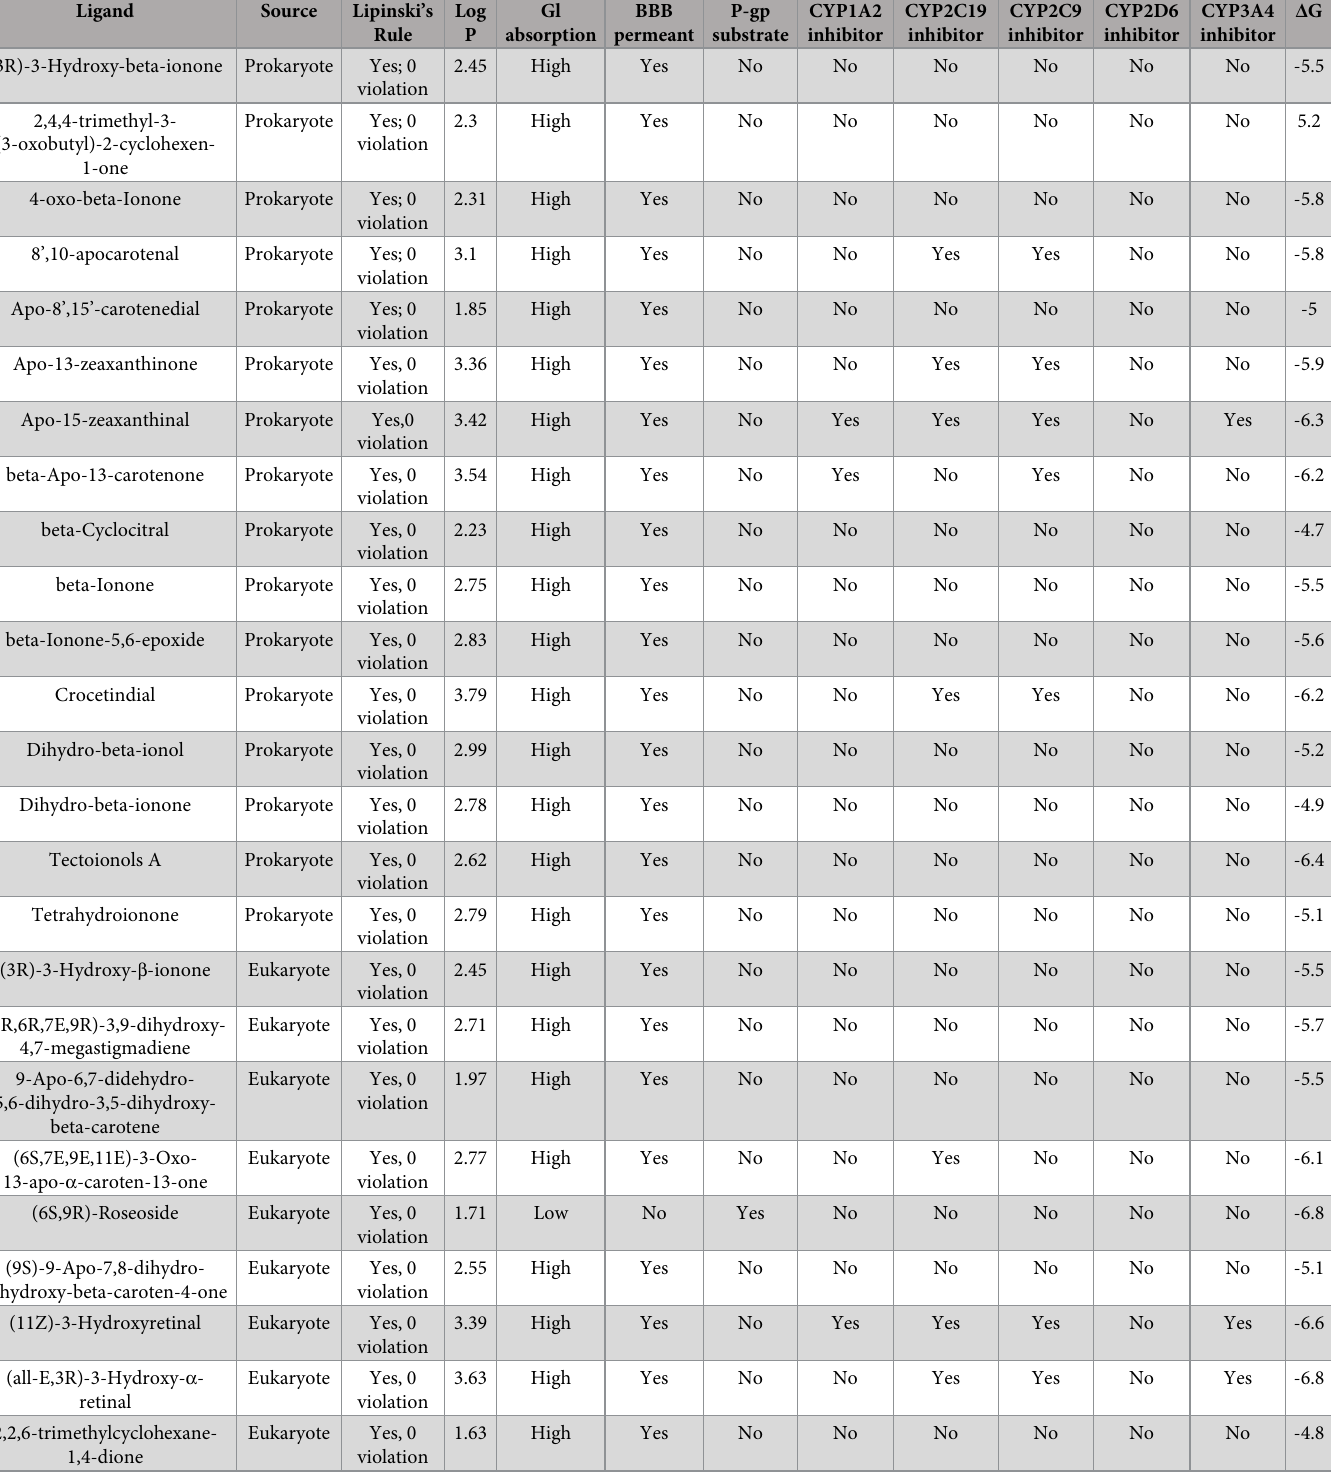
Table 1. Pharmacokinetic properties of 125 carotenoids with appropriate drug-likeness property.